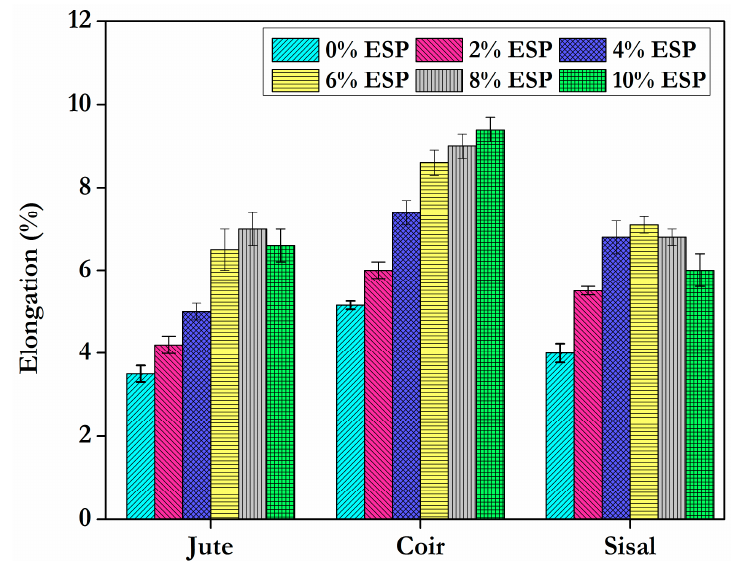
Figure 7. Elongationat tensile strength for tensile